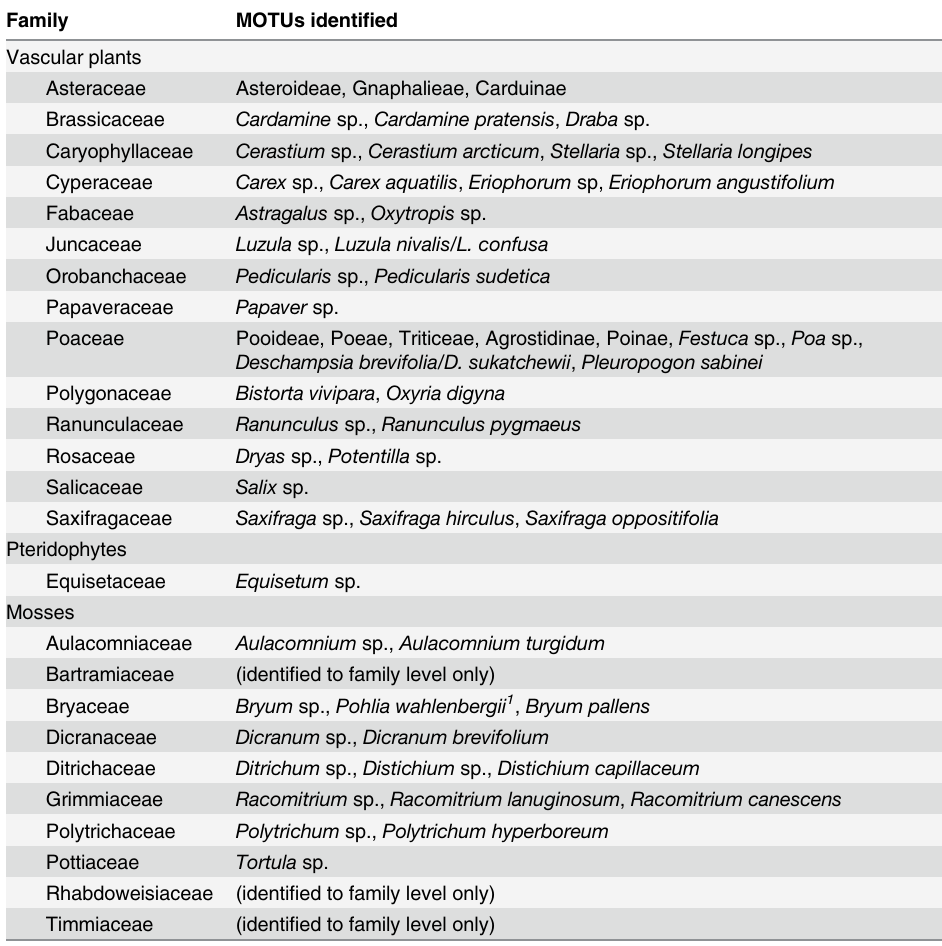
Table 1. Food items identi fi ed in lemming winter